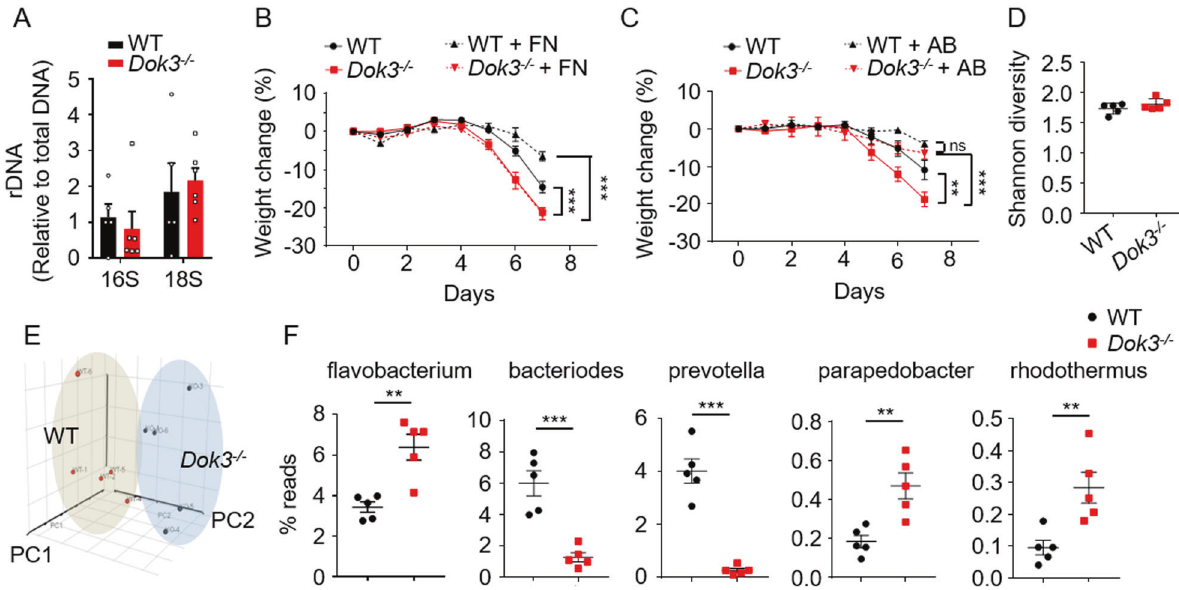
Fig. 2 DOK3 de fi ciency results in a dysbiotic colonic bacterial microbiome. A RT-qPCR analysis of 16S and 18S rDNA in fecal DNA obtained from WT and Dok3 − / − mice. Data is shown as mean ± SEM ( n = 5 – 6). B WT and Dok3 − / − mice were given fl uconazole (FN) in their drinking water for 2 weeks prior to the induction of DSS colitis. Body weights were measured daily. Data is shown as mean ± SEM ( n = 5). *** p < 0.0001, two-way repeated-measures ANOVA. C WT and Dok3 − / − mice were given antibiotics (AB) cocktail (vancomycin, ampicillin, neomycin, and metronidazole) in their drinking water for 4 weeks prior to the induction of DSS colitis. Body weights were measured daily. Data is shown as mean ± SEM ( n = 5). ** p = 0.01, *** p = 0.0005, two-way repeated-measures ANOVA. D – F High throughput sequencing of 16S rRNA in fecal bacterial DNA. D Shannon diversity of WT and Dok3 − / − mice fecal microbiota. Data is shown as mean ± SD ( n = 5). E Principal-component analysis of the microbiota composition in WT and Dok3 − / − mice. Each symbol represents an individual mouse. F Relative abundance of major bacterial genera in WT and Dok3 − / − mice fecal microbiota. Data is shown as mean ± SEM ( n = 5). ** p = 0.002, 0.004, 0.008, *** p = 0.0005, <0.0001 (from left to right), unpaired two-tailed Student ’ s t